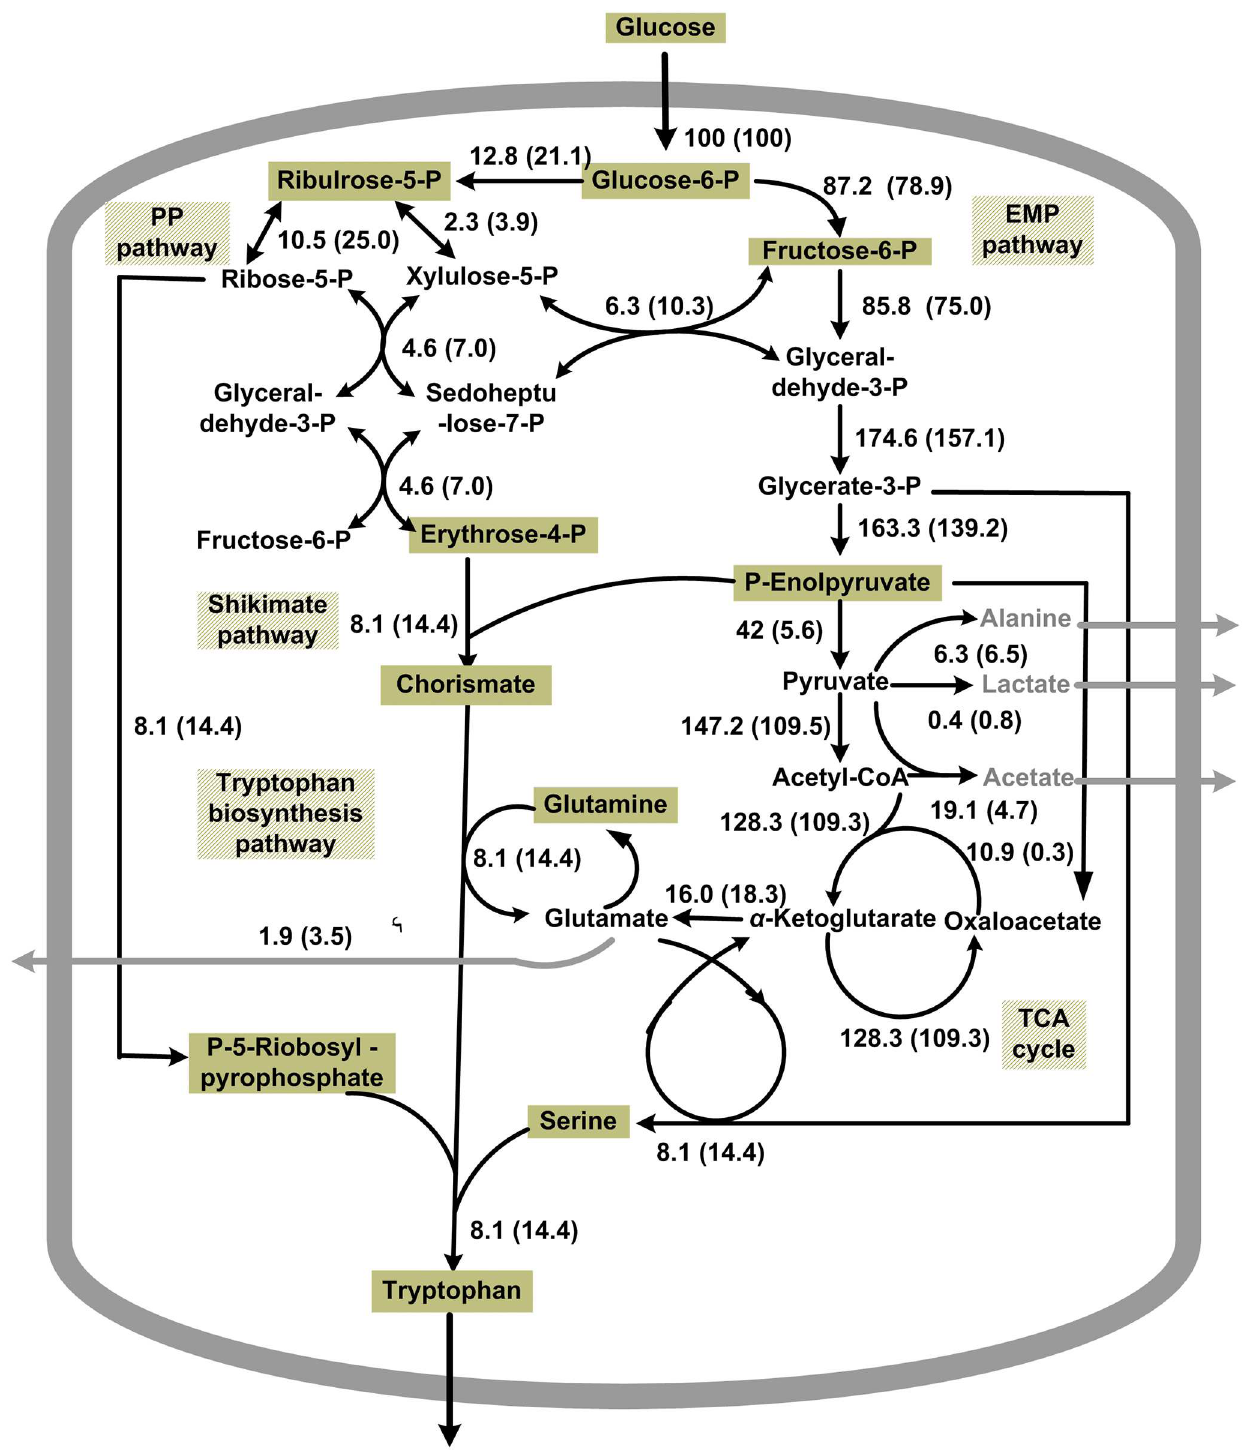
Fig 5. The metabolic flux distribution of TRTHB and TRTHBPA during the later fermentation period (30–40h) of L-tryptophan production. Values in parentheses represent the metabolicflux of TRTHBPA.